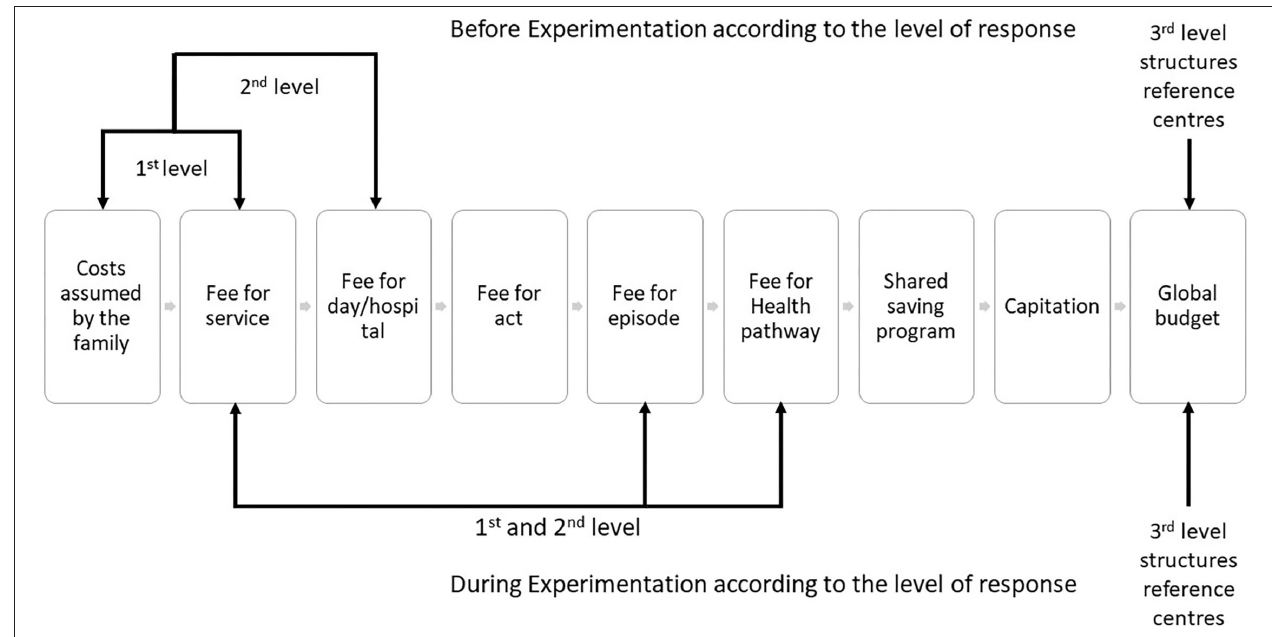
FIGURE 2 | Type of payment procedures in the experimental process: Parcours de Santé TSLA Occitanie (adapted from (60) with